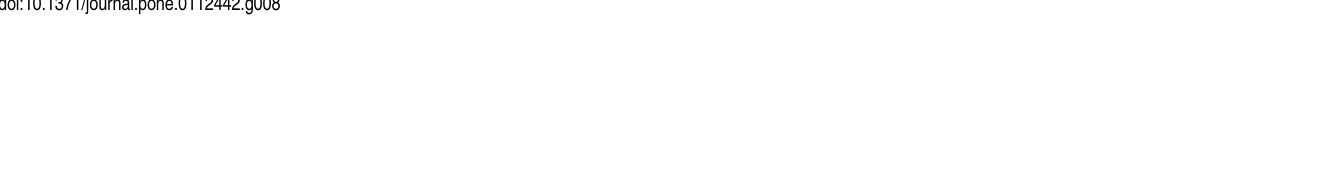
Figure 8. Annual solar irradiance absorbed by one square meter of a 2d-tracking flat-plate collector: (a) the direct beam and forward scattered circumsolar diffuse component, (b) the non-forward scattered diffuse component, and (c) the ground reflected component. Note that the magenta markers indicate the selected European locations referred to in table 5. Note also that the color scales differ between the subfigures.